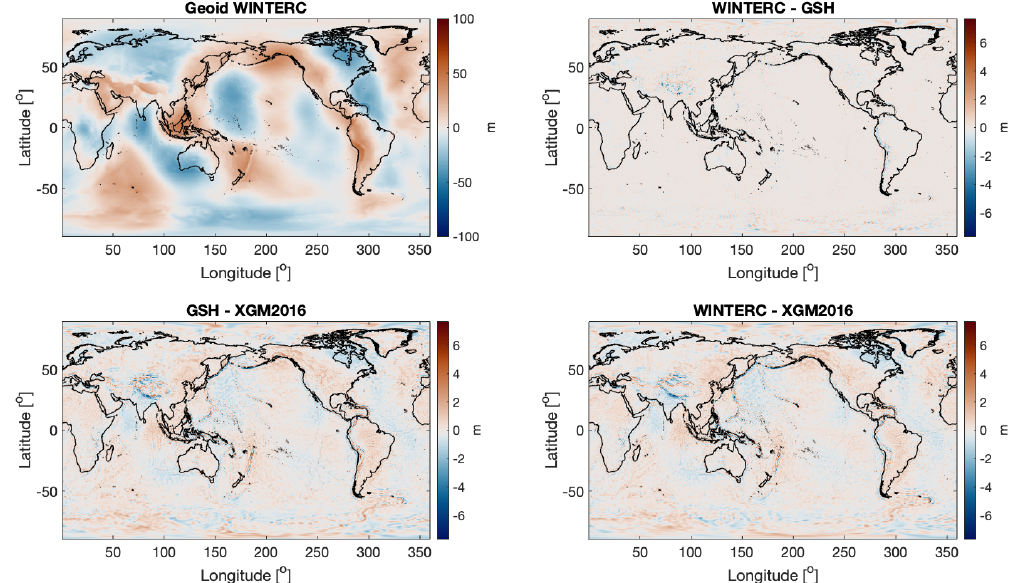
Figure 8. Geoidal differences comparing the solutions made by the WINTERC-G-based code, the solution from GSH, and the observed XGM2016 gravity field on which WINTERC-G is based. Spherical harmonic coefficients 4–359 ◦ and order are